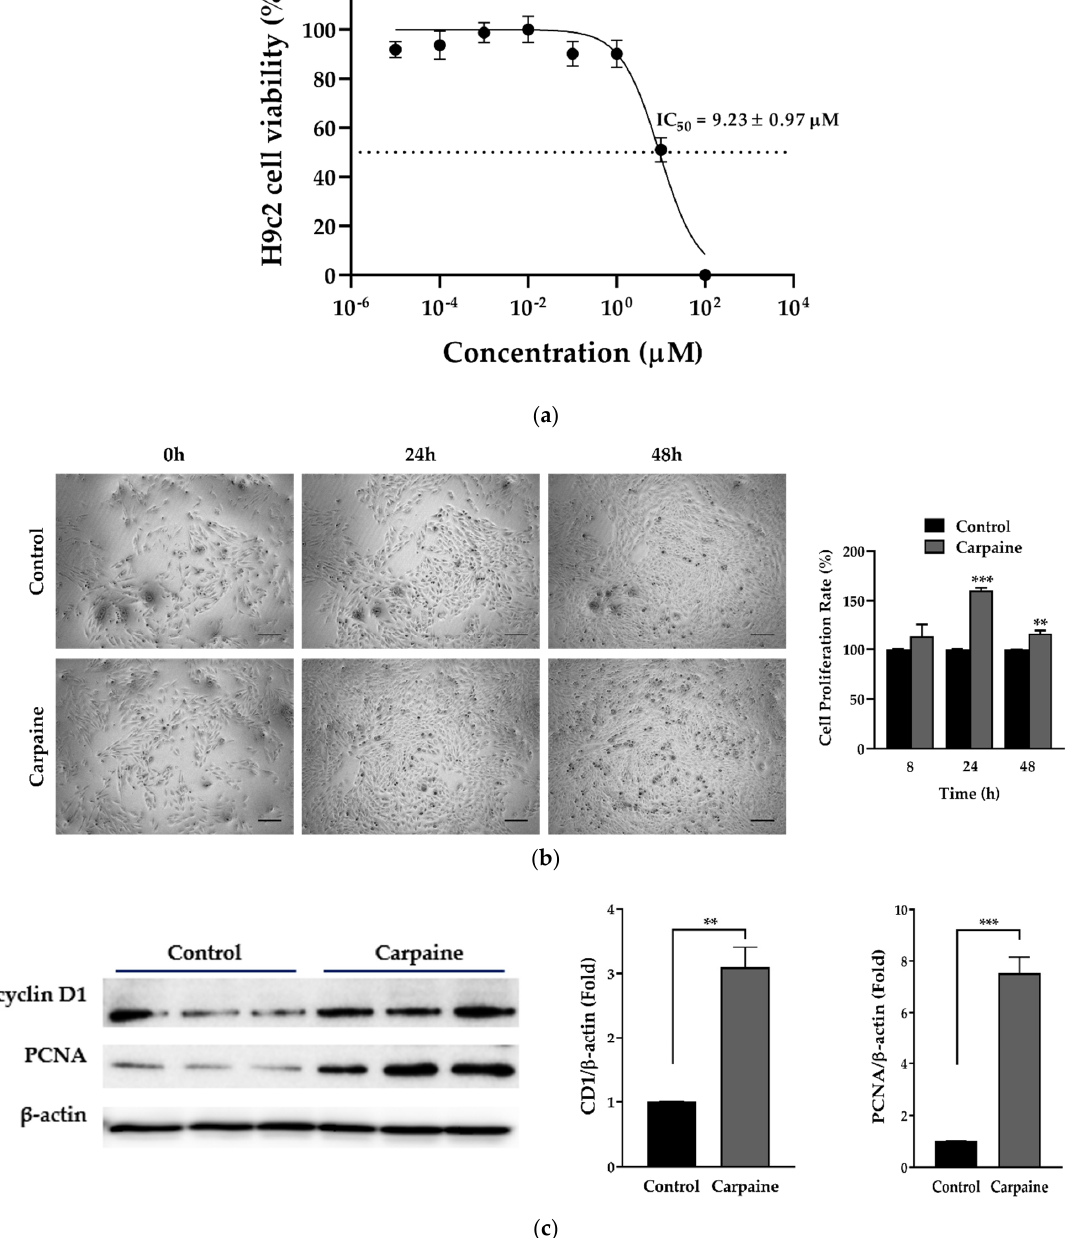
Figure 1. Carpaine promotes cell proliferation in H9c2 cells. ( a ) Cytotoxicity effect of carpaine on H9c2. Cells were treated with serial dilution of carpaine for 24 h to determine the 50% inhibitory concentration (IC 50 ) ( n = 6). ( b ) The effect of carpaine on the H9c2 proliferation rate. Representative images of H9c2 proliferation rate induced by carpaine treatment and quantitative analysis of cell proliferation. H9c2 treated with or without carpaine (1 µ M) for 8, 24, and 48 h. Scale bar: 200 µ m. ( c ) Carpaine promotes the activation of proliferation markers. H9c2 cells were treated with or without carpaine (1 µ M) for 30 min ( n = 3). Representative Western blot images of cell cycle markers and the quantification of cyclin D1 and proliferating cell nuclear antigen (PCNA) levels, normalized to β -actin. The protein band intensity is expressed as the fold change compared to control (non-treated group). Quantitative data are shown as the means ± SEM ( n = 3). ** p < 0.01, *** p < 0.001, significantly different, as indicated by unpaired